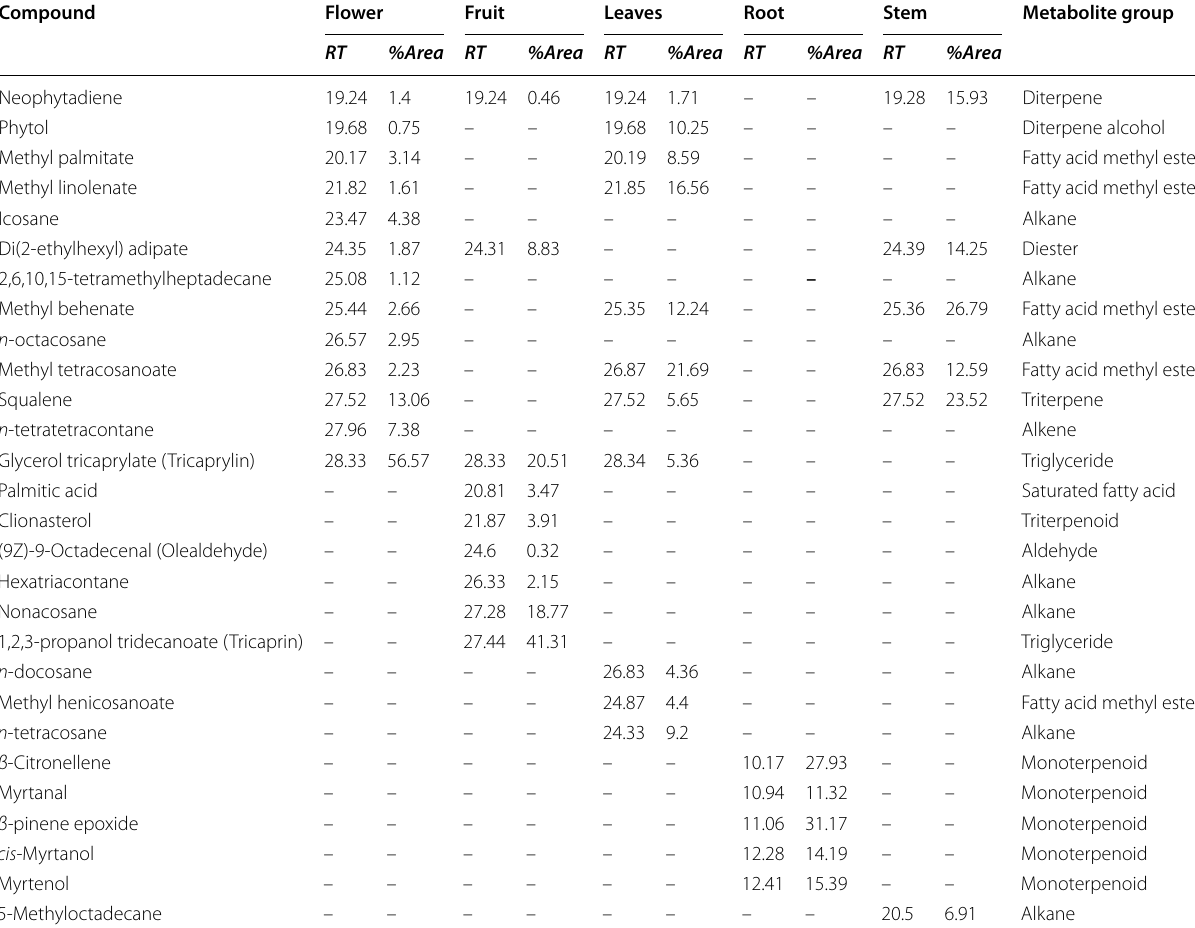
Table 3 GC–MS profile of the different parts of B.